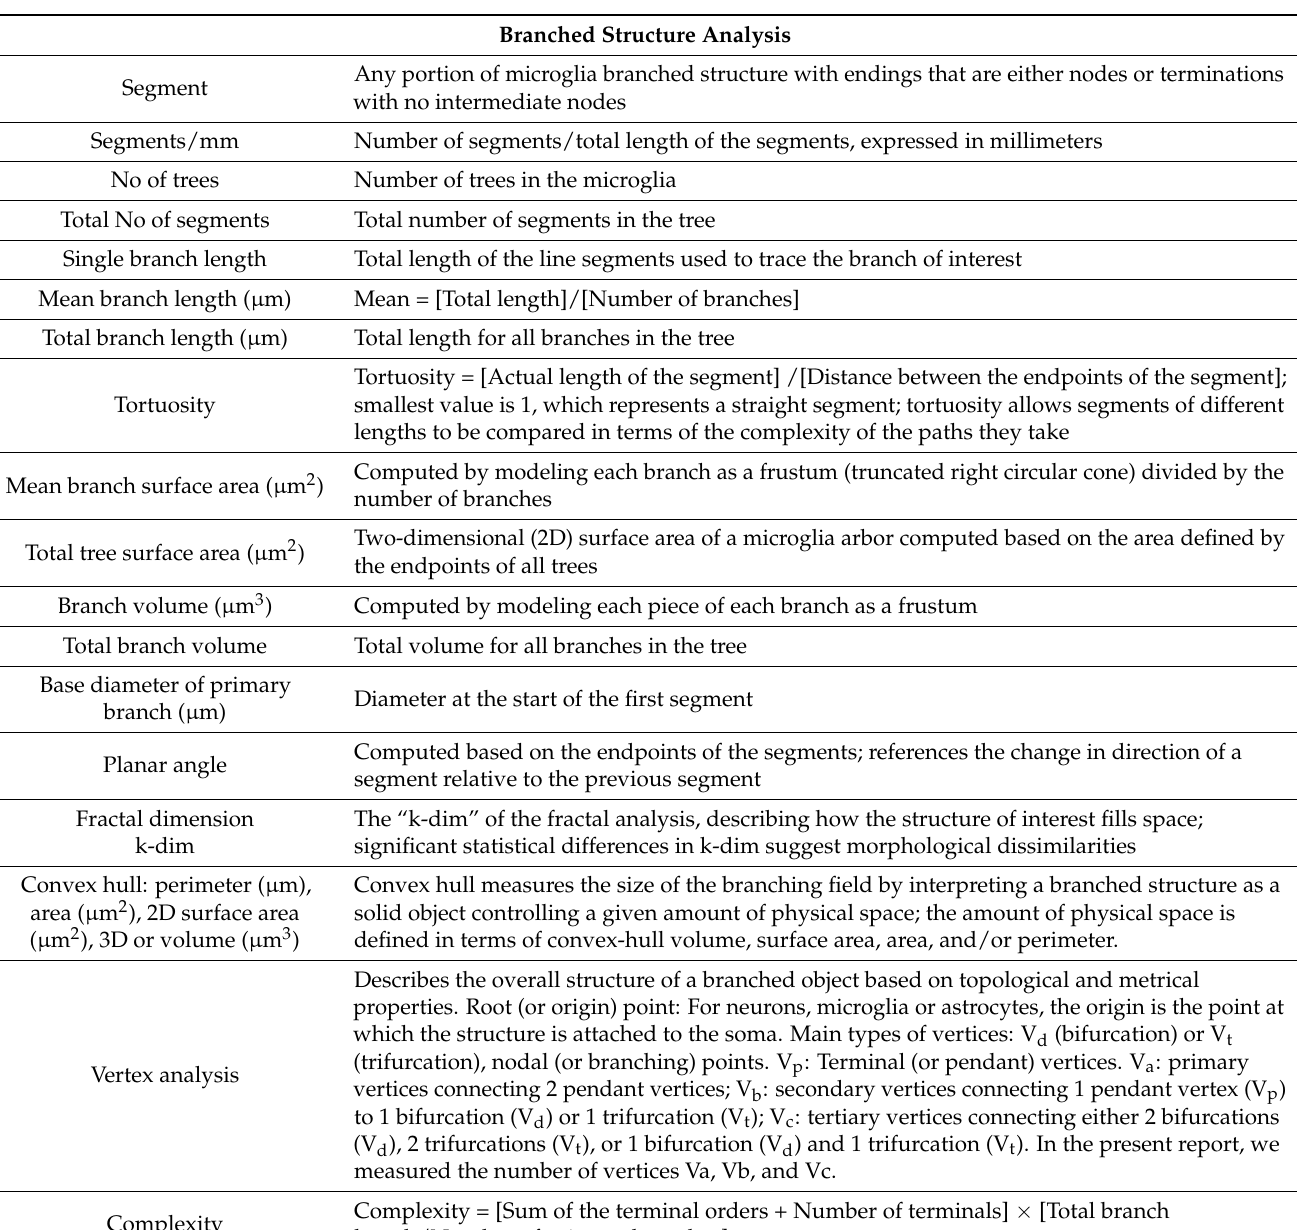
Table 1. Morphological measurements of microscopic 3D